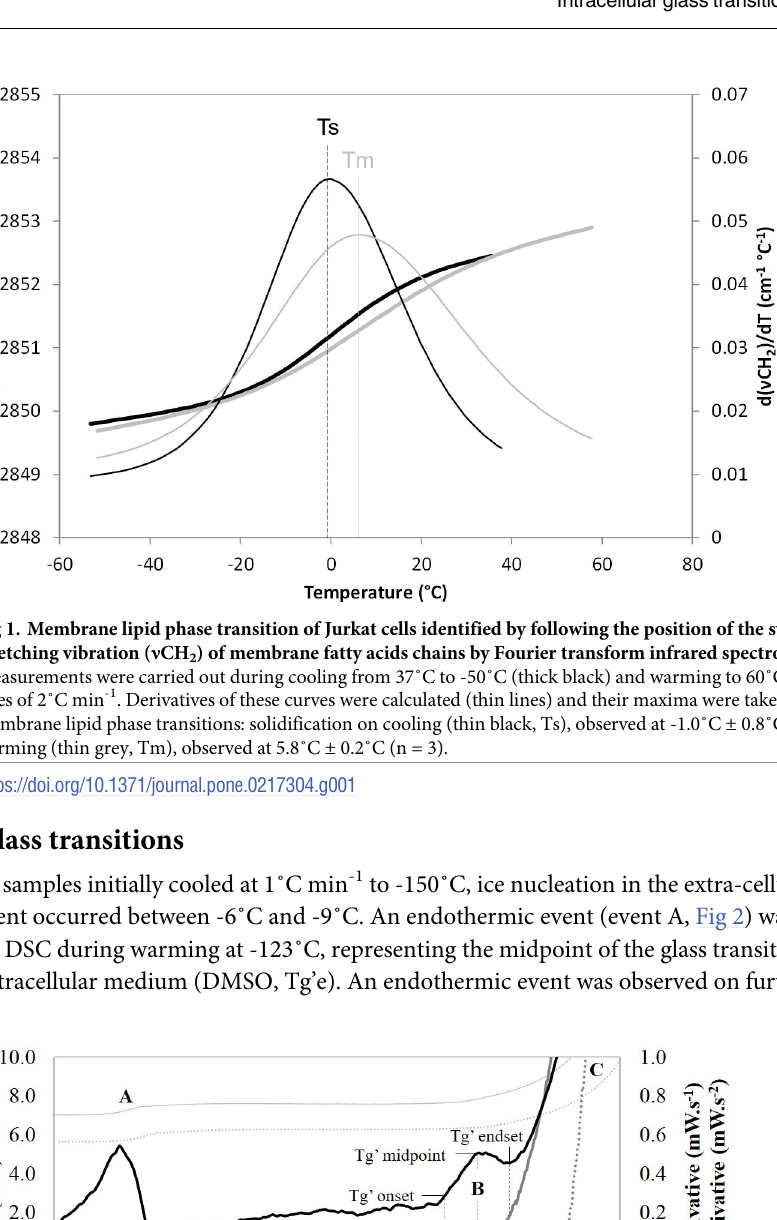
Fig 2. A typical DSC trace of Jurkat cells (solid lines) and cell-free supernatant (dotted lines) during warming, and their first-order (grey) and second-order (black) derivatives. Both samples were separated by centrifugation from a suspension of Jurkat cells in culture medium with 10% (v/v) dimethyl sulfoxide. They were initially cooled at 2˚C min -1 to -150˚C. Three distinct thermal events are apparent: the extracellular glass transition (A), the intracellular glass transition (B), and bulk melting of the extracellular solution (C). Note that transition B, characterized by its onset, maximum and endset, is absent in the DSC trace of the cell-free supernatant.